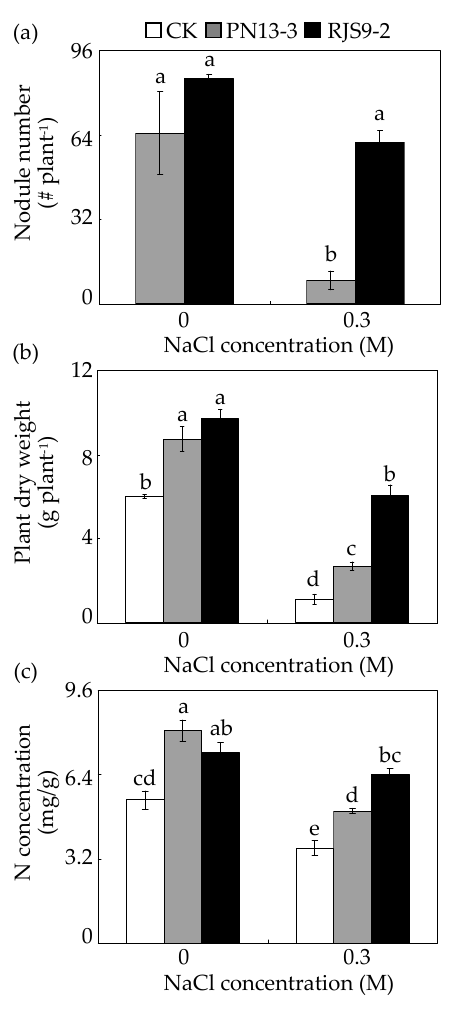
Figure 6. Plant and nodule growth affected by rhizobial inoculation and salt stress. ( a ) Nodule number; ( b ) Plant dry weight; ( c ) N concentration. Twenty-four-day-old seedlings without (CK) or with rhizobial inoculation were transplanted into nutrient solution under 0 or 0.3 M NaCl treatment. The shoots, roots, and nodules were harvested separately after 40 days of NaCl treatments. A column represents mean value obtained from three biological replicates and bar represents standard error. An individual hydroponics box contained three seedlings was regarded as one biological replicate. The same letter indicates no significant difference at p < 0.05 (Duncan’s test). # indicates the number of nodule.